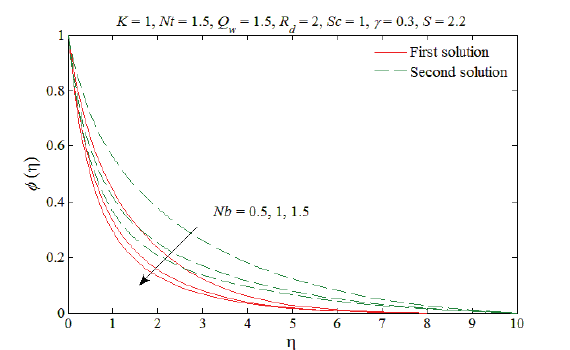
Fig. 5: The concentration profiles for different values of Nb